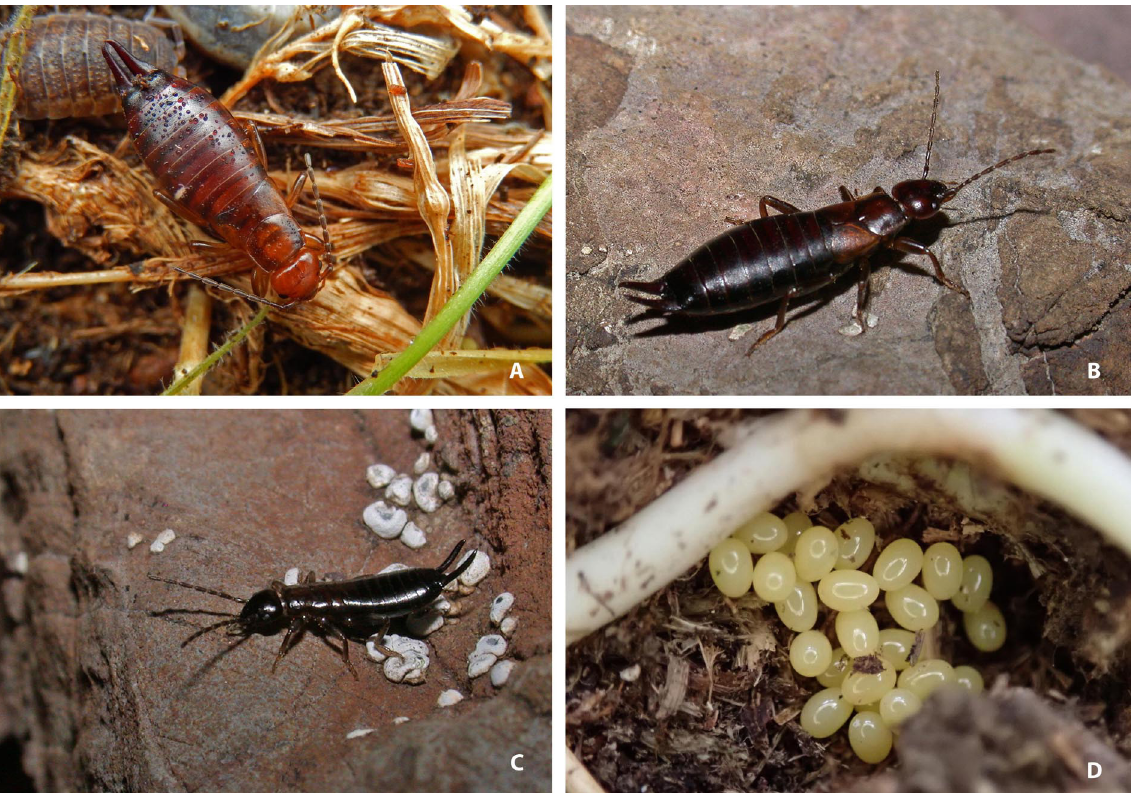
Fig. 5. Live specimens of Pseudochelidura cantabrica Cuesta-Segura, Jurado-Angulo & García-París sp. nov. A . Female from Puerto de la Farrapona (León, Spain). B . Female from Puerto de Ventana (León, Spain). C . Early instar nymph from Puerto de Ventana (León, Spain). D . Eggs from Puerto de Vegarada (León, Spain). Photographs in situ by ADC-S (A, D) and ex situ by MG-P